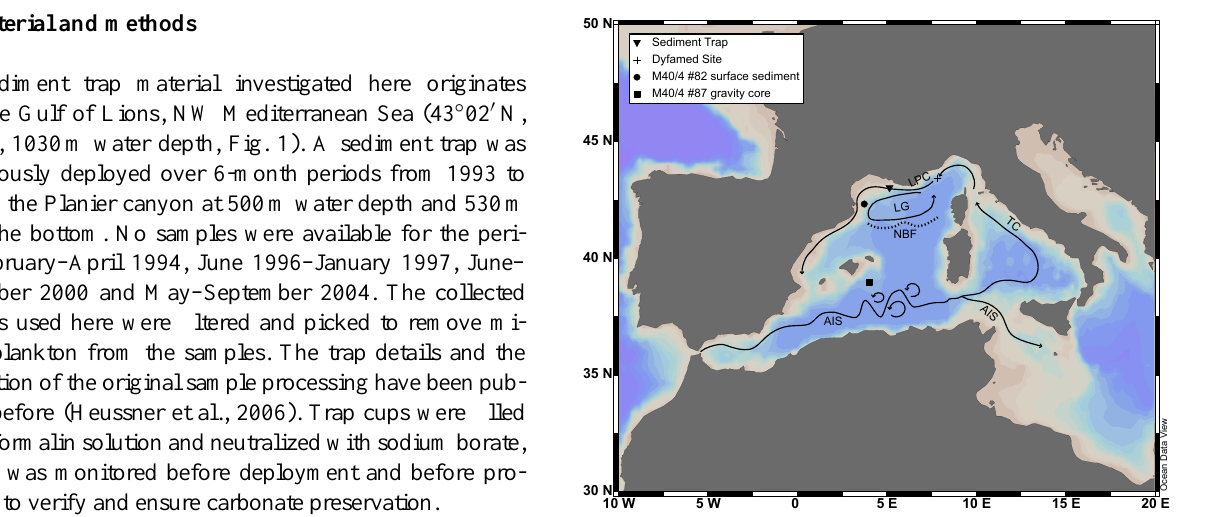
Figure 1. Map of the NW Mediterranean Sea. Location of trap, DYFAMED site, surface sediment sample, sediment core and the major oceanographical currents and fronts (LPC: Liguro–Provençal Current (Northern Current), LG: Lion Gyre, AIS: Atlantic–Ionian Stream, TC: Tyrrhenian Current, NBF: North Balearic Front). After Millot (1987) and Pinardi and Masetti